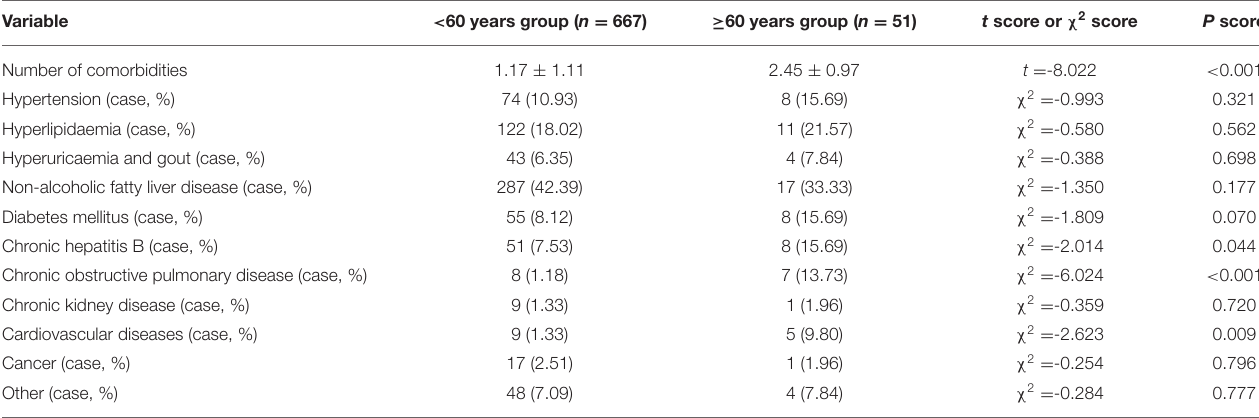
TABLE 4 | Comparison of comorbidities between < 60 years group and ≥ 60 years group ( n = 718).